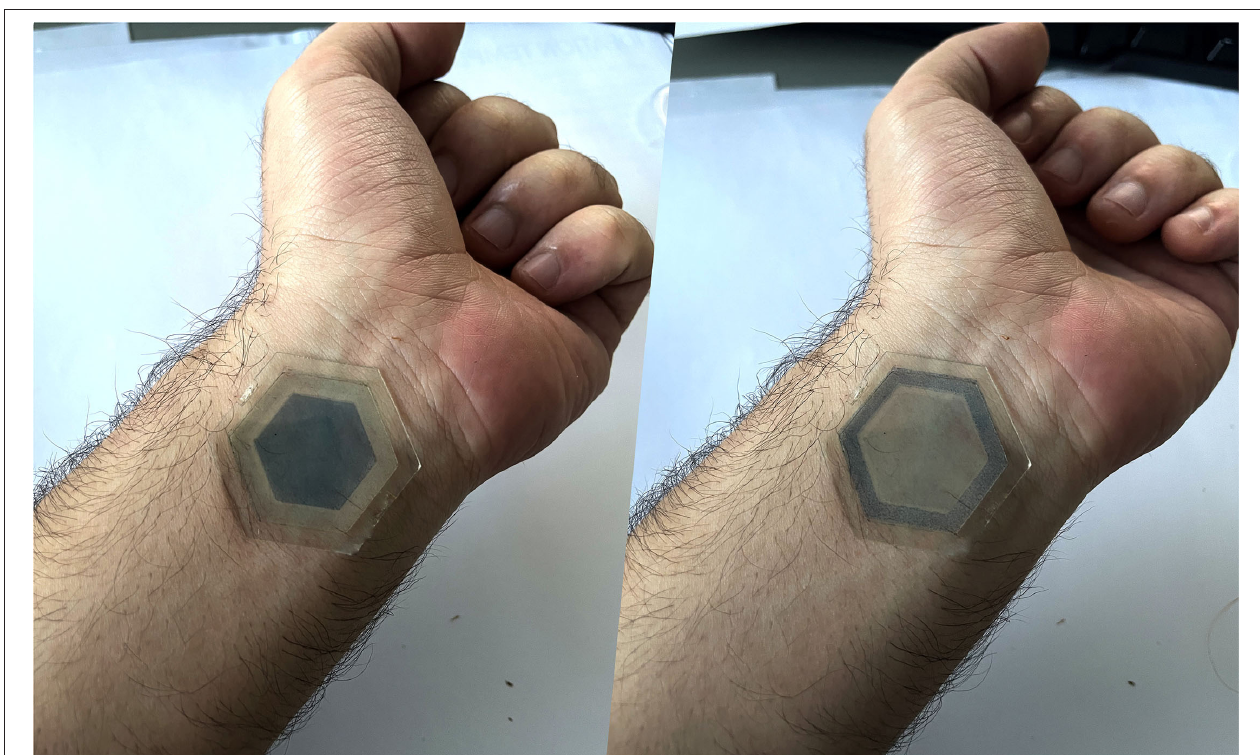
FIGURE 2 | Two states of a skin-attached interactive tattoo with electrochromic